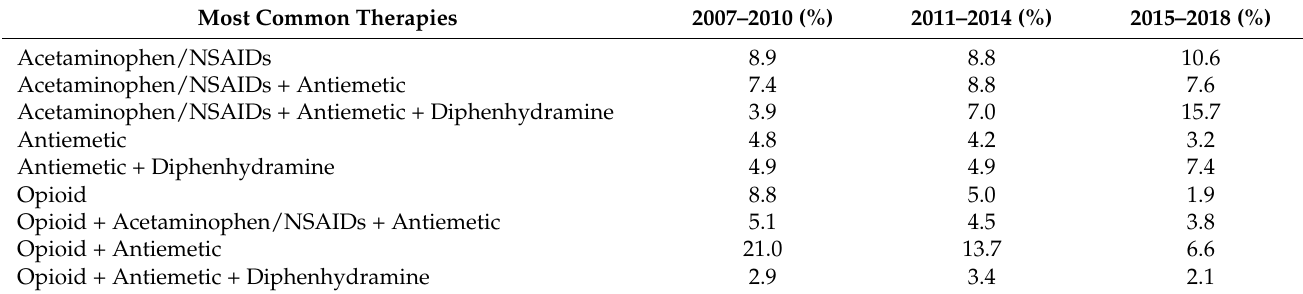
Table 3. Most common therapies administered among headache-related ED visits: 2007 to 2018 NHAMCS